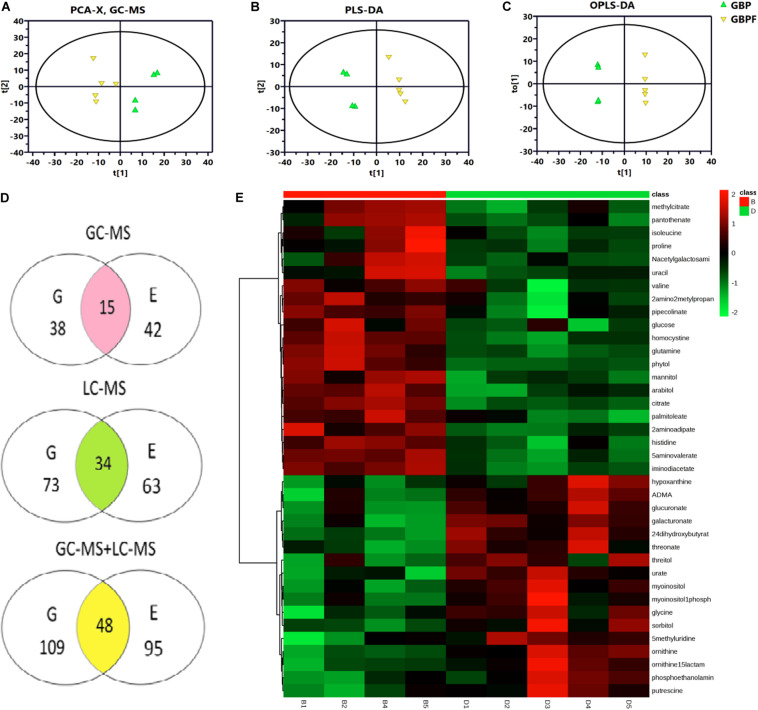
Metabolomics analysis of germ (G) and endosperm-bran (E) fractions between black point-affected (BP) and black point-free (BPF) wheat kernels. (A–C) Model scores plots comparing GC-MS data for EBP and EBPF kernels. (A) Principal component analysis (PCA; R2X = 0.565); (B) Partial least-squares-discriminate analysis (PLS-DA; R2Y = 0.998, Q2 = 0.930). (C) Orthogonal partial least-squares discriminant analysis (OPLS-DA, R2Y = 1.000, Q2 = 0.928). (D) Metabolites with differential content between BP and BPF identified by GC-MS and LC-MS. Values indicate the number of metabolites in a group. Data in the shaded cross-section count metabolites found in both G and E fractions. (E) Heat map of differential metabolites from the G fraction of BP and BPF as measured by GC-MS (n = 5). Each line represents a metabolite, and each column id represents a sample. B1–B5 and D1–D5 label BP and BPF replicates, respectively. Upregulated metabolites are shown in red, and downregulated metabolites are shown in green.